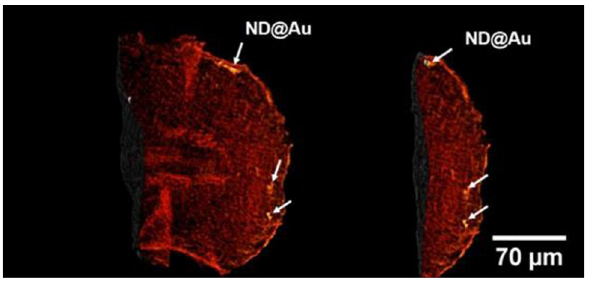
Figure 7. Tomographic volume rendered structure of hard X-ray micrographs of the 5-day-old zebrafish larvae’s tail. Injection of 2 mg/ml (4.6 nl) ND@Au into zebrafish embryo before 4 cell stage.